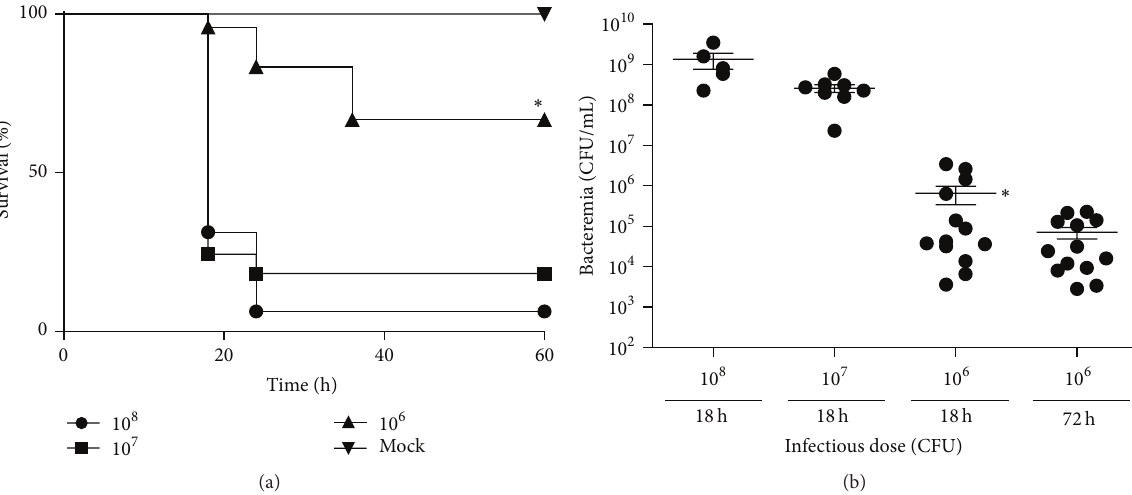
Figure1:SurvivalcurvesandbacteremialevelsofGBS-infectedC57BL/6mice.(a)Mice( 𝑛 = 16 )wereinjectedintraperitoneallywithdifferent doses of wild-type GBS serotype III strain COH-1 and survival levels recorded. Mock-infected animals (injected with the vehicle solution) were used as controls. (b) Systemic bacteremia levels of infected mice were monitored at 18h after infection (for mice infected with 10 6 , 10 7 , and 10 8 CFU) and at 72 h after infection (for mice infected with 10 6 CFU). Blood was drawn by tail puncture and serially diluted in PBS prior to plating on blood agar dishes. Individual colonies were counted and data expressed as CFU/mL of blood. ∗ 𝑃 < 0.05 , compared to higher infectious